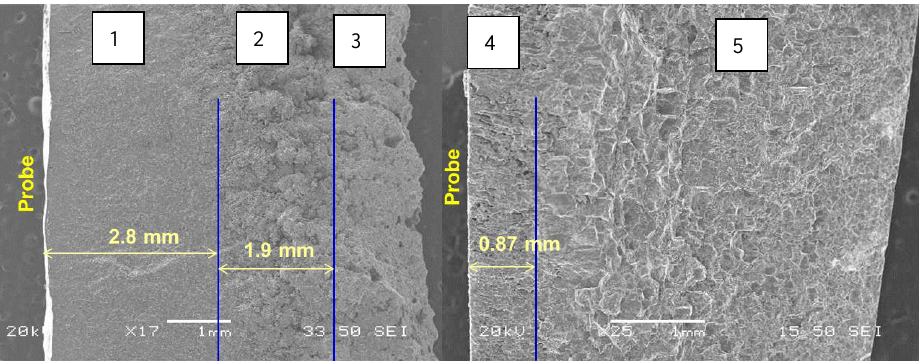
Figure 1. Structure of transient ( left ) and steady-state ( right ) samples, revealed by SEM-SEI (SEM: Scanning Electron Microscope; SEI: Secondary Electron Imaging) images of frozen bath surfaces cut in a perpendicular direction to the probe-sample contact interface